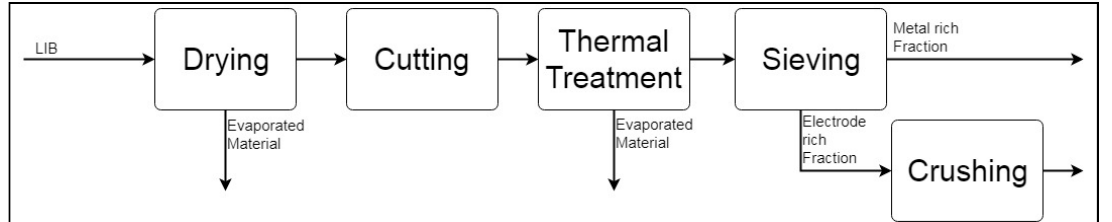
Figure 4. Flowsheet of the pre-processing stages for the recycling of Lithium-ion battery (LIB) described by [9,21].